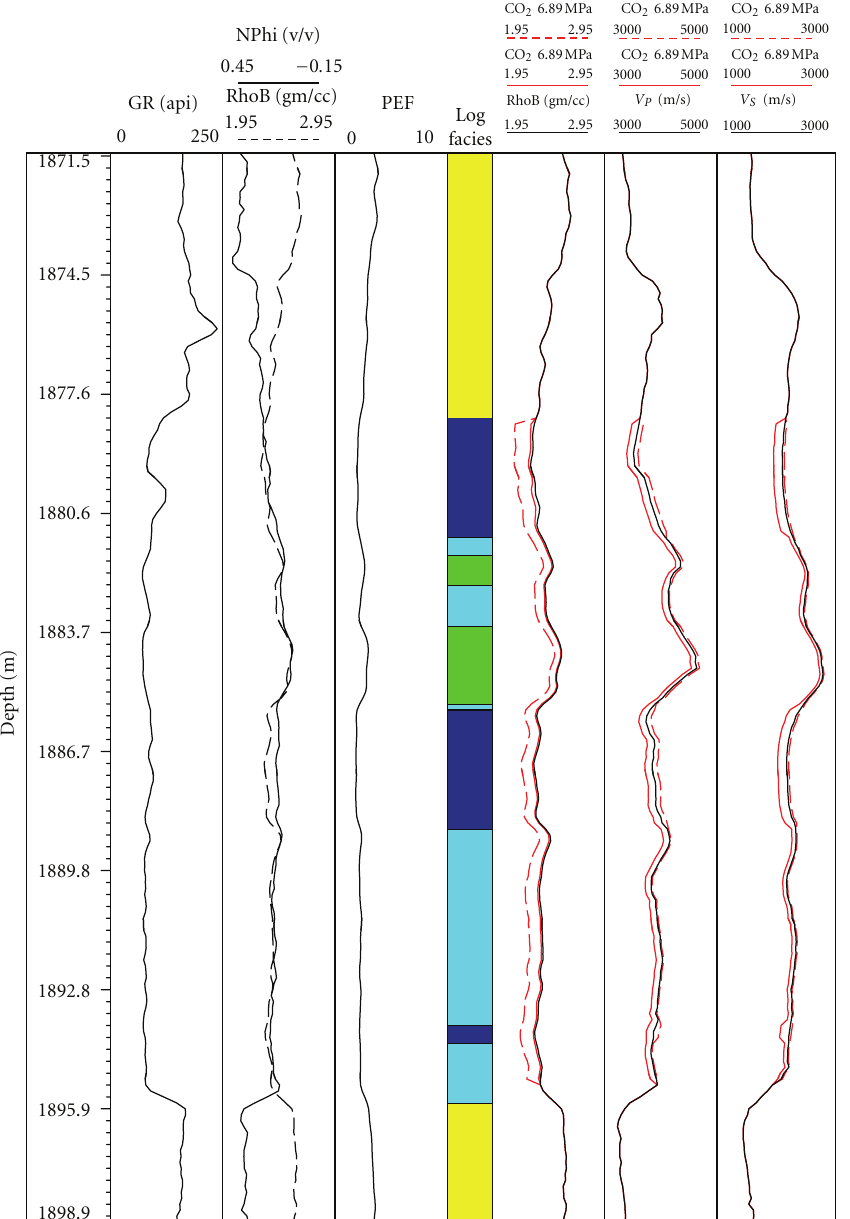
Figure 17: Estimated changes in the Morrow A sandstone for P-wave velocity, S-wave v.elocity, and bulk density log response for conditions of complete CO 2 saturation at pore pressures of 6.89 MPa (red dashed lines) and 29.65 MPa (solid red lines). The recorded in-situ P-wave velocity, S-wave velocity, and bulk density logs are shown in black.